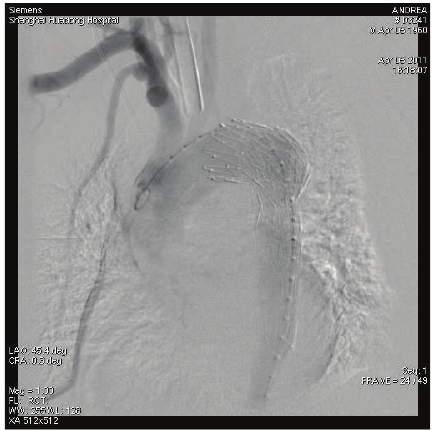
Figure 3: False lumen disappeared under DSA right after graft-stent was inserted into place.